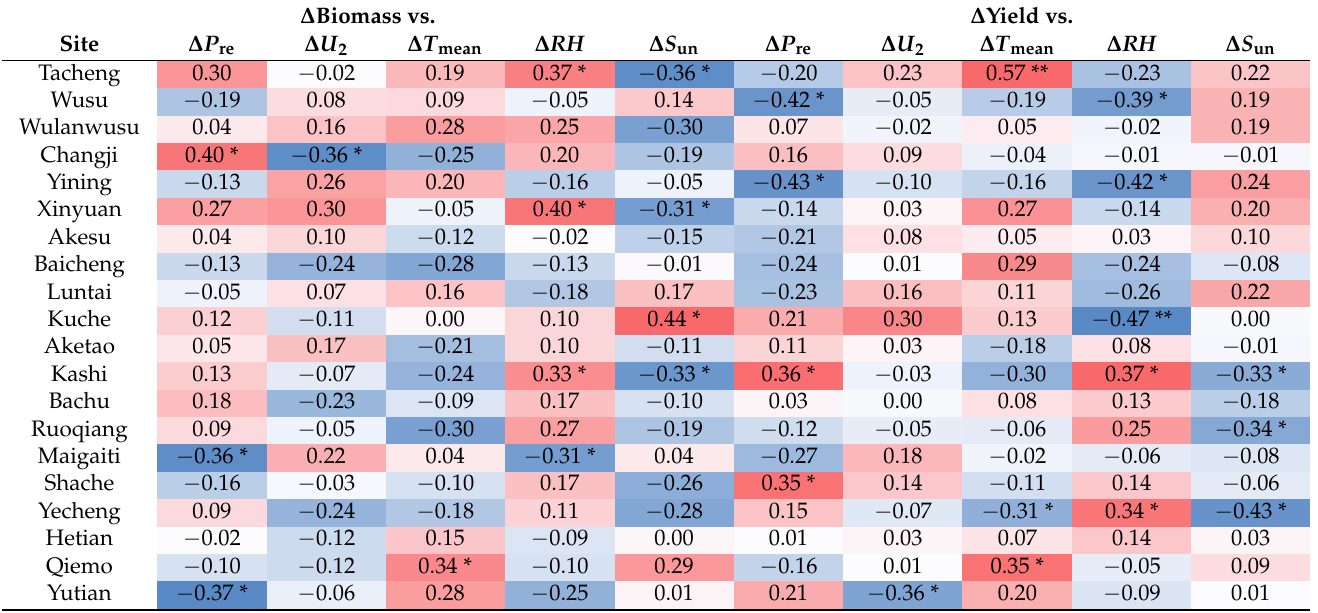
Table 3. The Pearson correlation coefficients between first differences of two growth indices, biomass or yield and climatic variables, over 1981–2017 at the 20 sites in Xinjiang, China. Red and blue grids represent positive and negative correlations, respectively. ∆ Biomass vs.